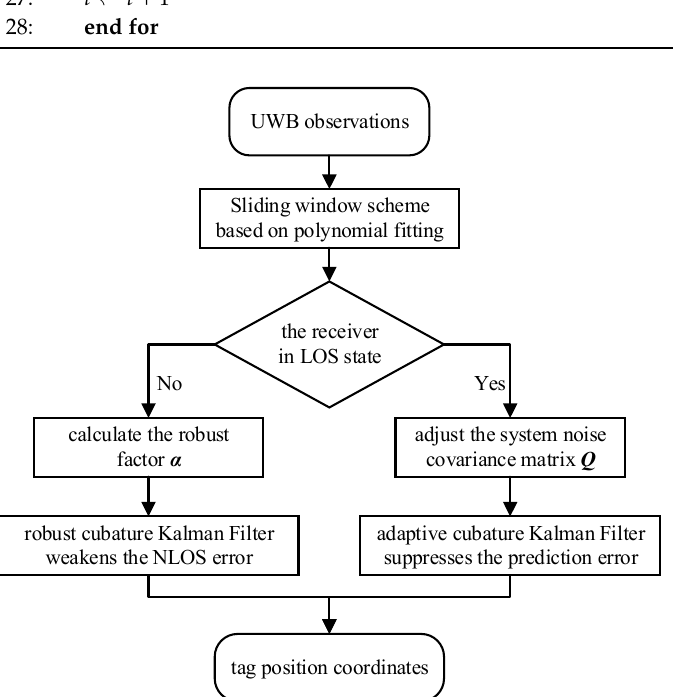
The flow chart of the IRACKF is shown in Figure 5.